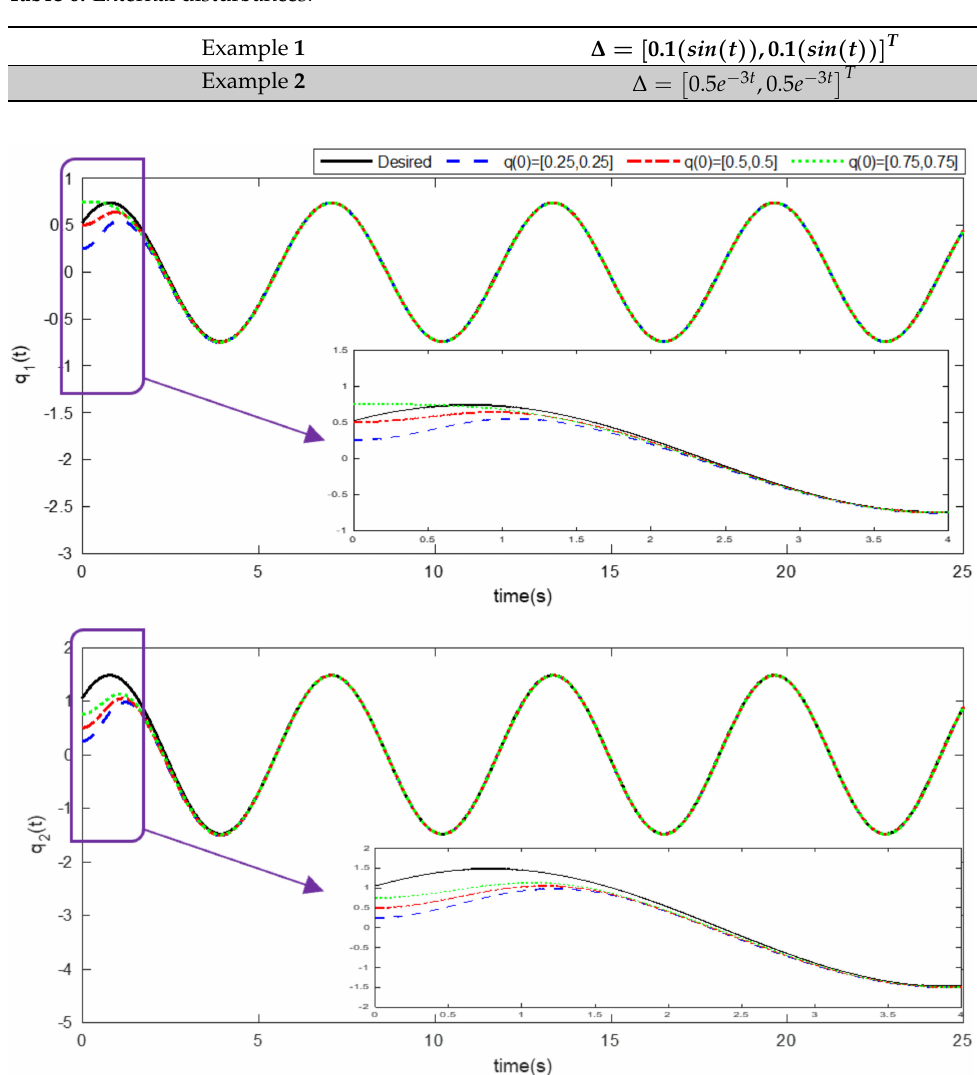
Table 6. External disturbances.